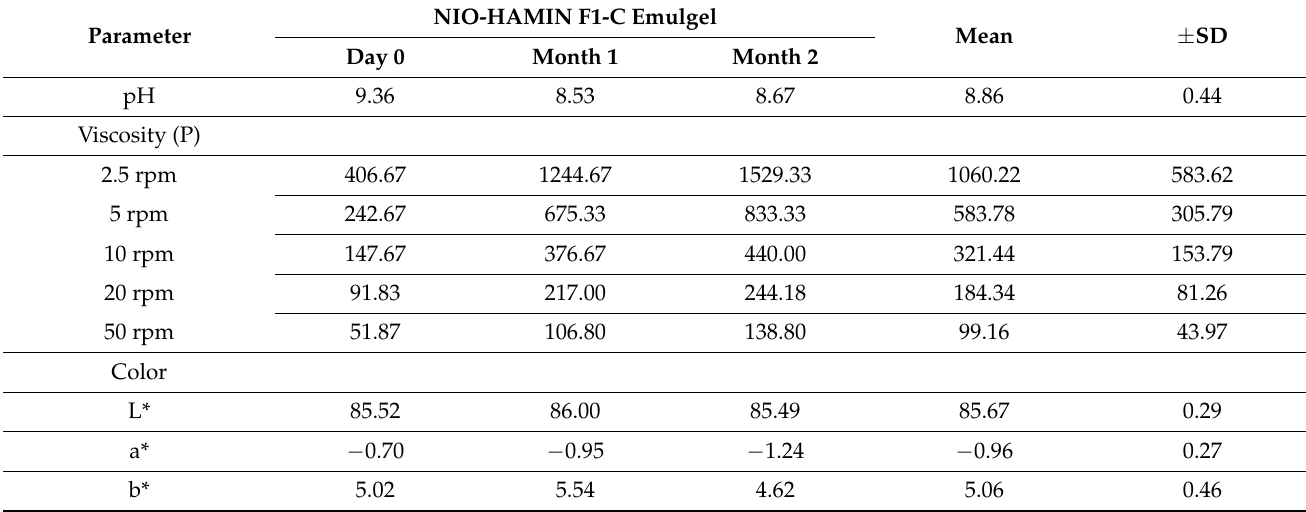
Table 2. NIO-HAMIN F1-C emulgel formulation characterization.